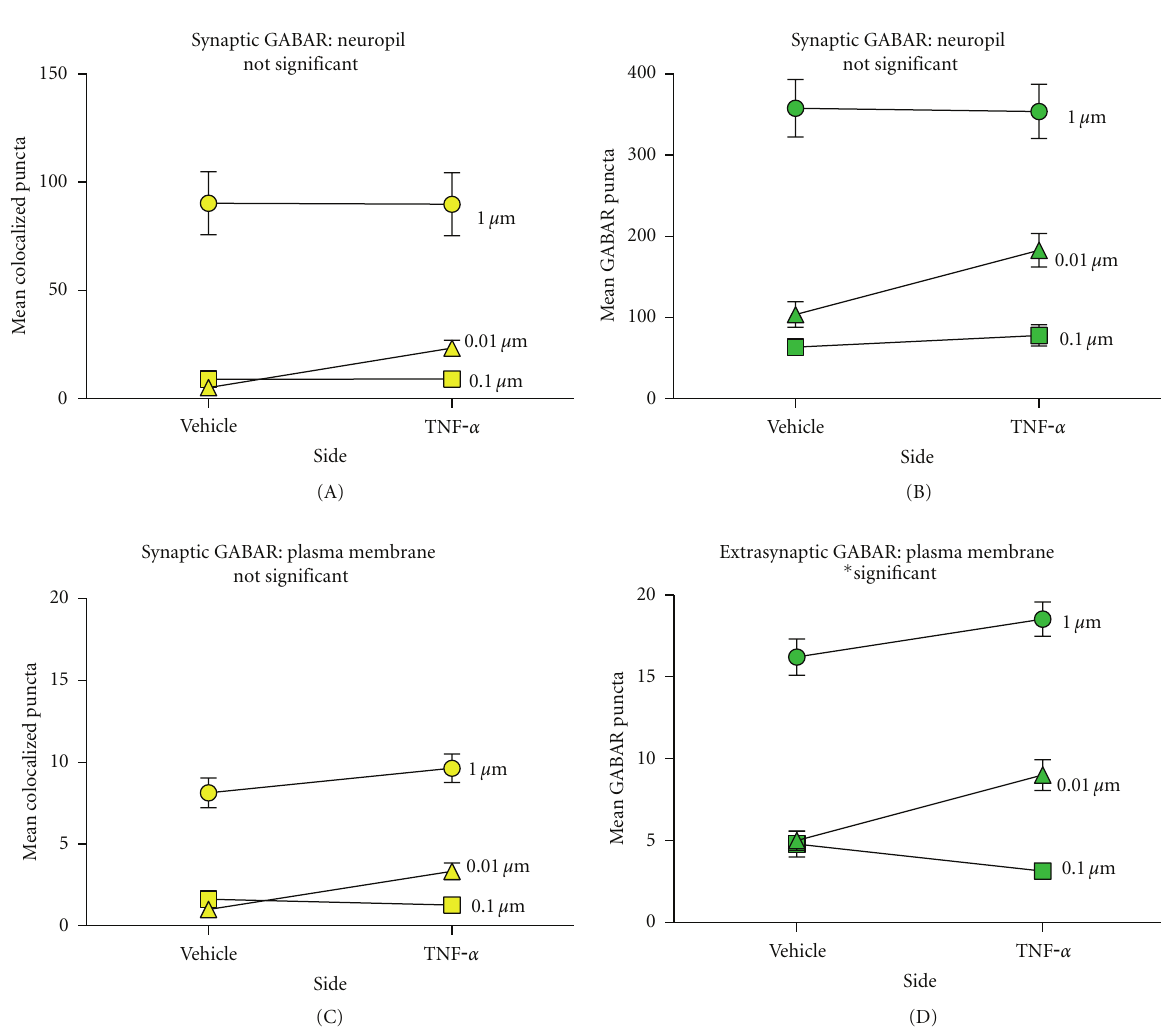
Figure 6: Two-way interactions of drug dose and injection side. ((a)–(d)) There was a significant e ff ect of dose across all outcomes ( P < 0 . 001). High doses of TNF α had a widespread e ff ect extending onto the contralateral side of the cord such that there was no e ff ect of injection side across any outcome ( P > 0 . 05). ((a)–(c)) A 2-factor mixed ANOVA revealed that there was not a significant interaction between dose and side on total GABA A R on the neuropil, synaptic GABA A R on the neuropil, or plasma membrane ( P > 0 . 05); yet there was a significant e ff ect of interaction for extrasynaptic GABA A R on the plasma membrane ((d) P = 0 . 037).